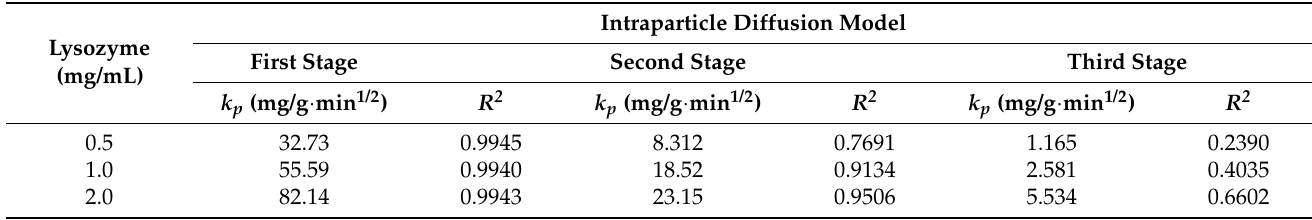
Table 3. Kinetic values calculated by intraparticle diffusion kinetic model for lysozyme adsorption onto P-COOH-CS-RG19 nanofiber membrane at different dye concentrations.